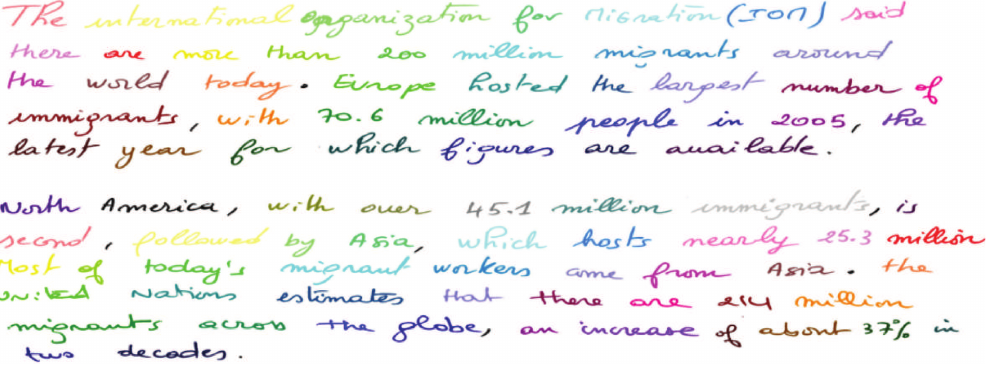
Figure 4: An Instance of GT Image Where Words are Colored Differently.